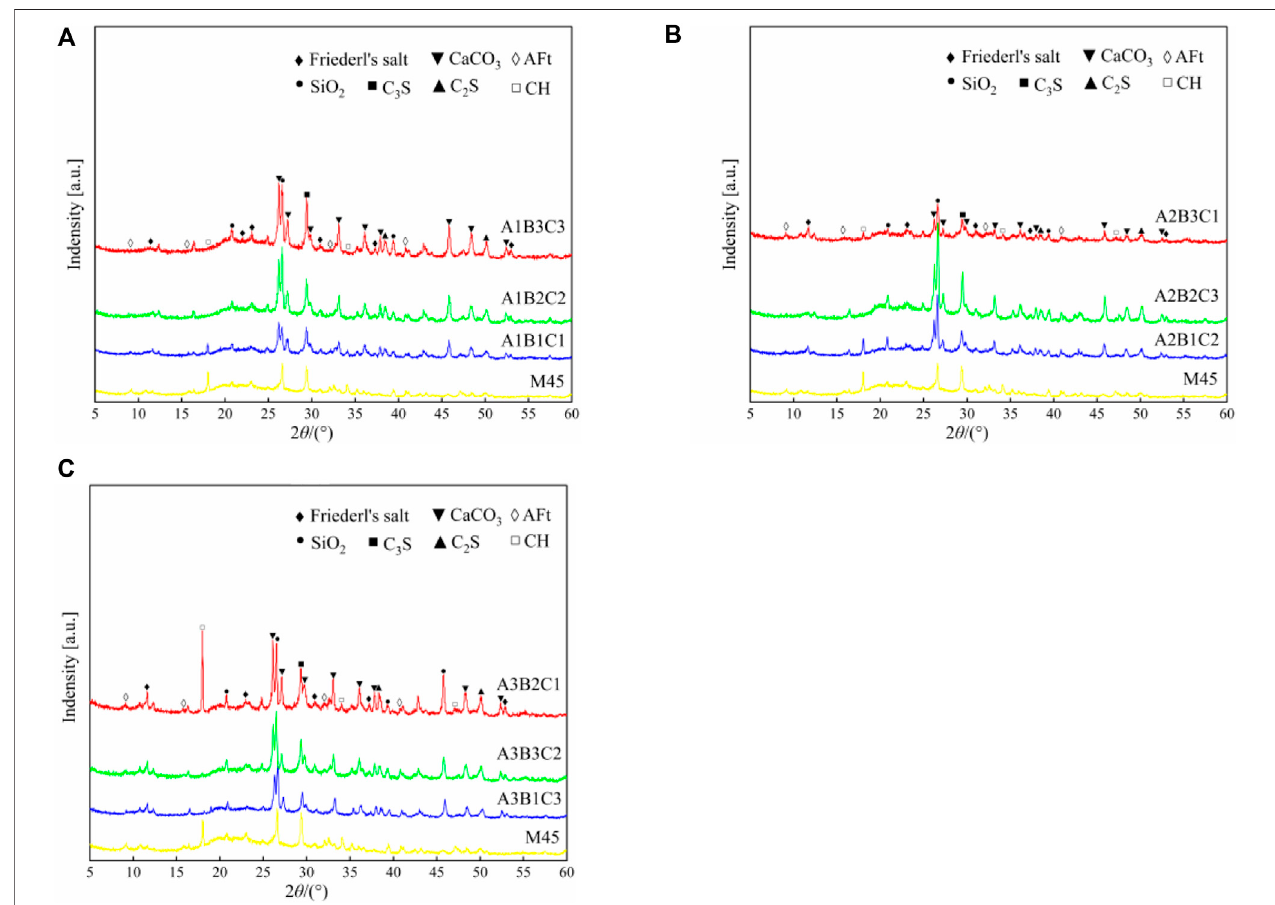
FIGURE 8 | X-ray diffraction pattern for SECC and M45. (A) : The sea sand content is 60%; (B) : The sea sand content is 80%; (C) : The sea sand content is 100%.